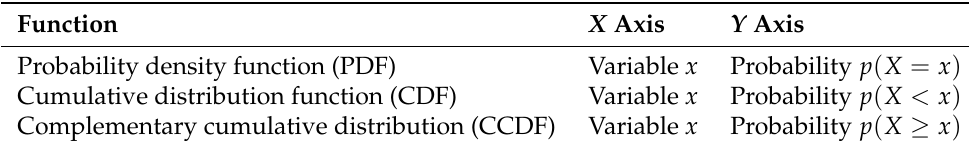
Table 5. Functions to study heavy-tailed distribution